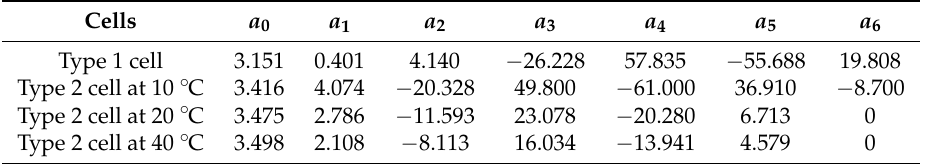
Table 2. The identification results of SOC-OCV coefficients for two types of cells.